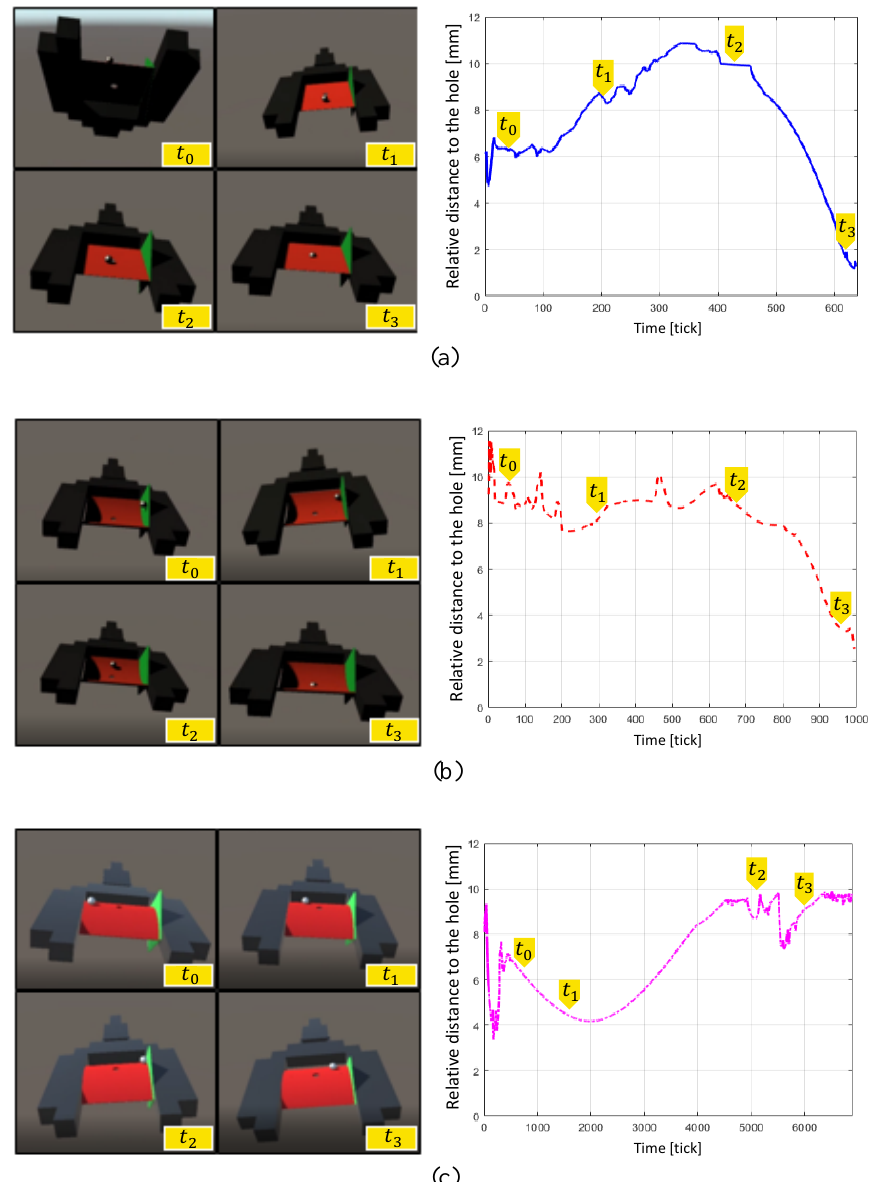
Figure 7. Snapshots ( left ) and corresponding relative distance to the hole ( right ) while the robotic agent is solving the geduldspiele cubes in the simulation world: ( a ) flat plane, ( b ) convex plane, and ( c ) concave plane. Time stamps are marked by t 0 through t 3 . The flat cube and the convex cube are solved, but the concave is